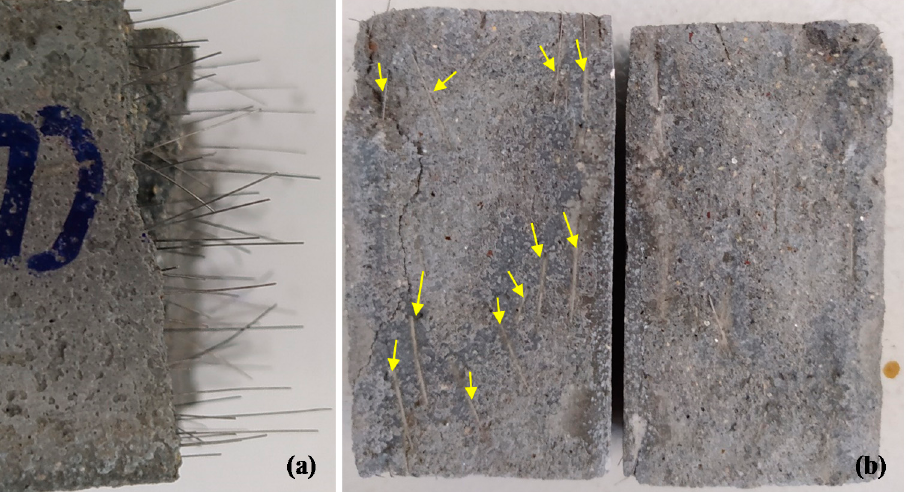
Figure 17. The fiber alignment parallel to the printing direction ( a ), ineffective fibers on the layer interface of the printed specimens subjected to the shear bond test ( b ).